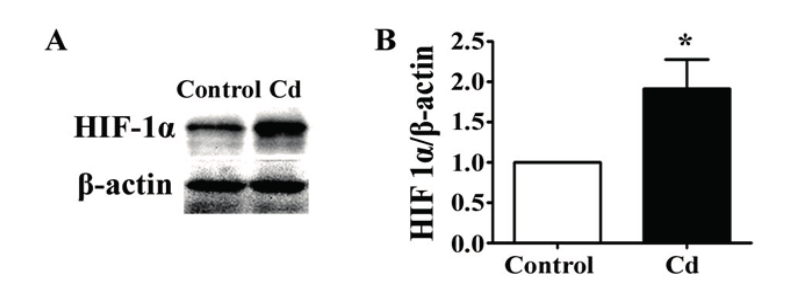
Figure 4. The effects of Cd on HIF-1 α in A549 cells. ( A ) Representative immunoblot of HIF-1 α and β -actin in 1 μ M Cd-treated A549 cells for 24 h. ( B ) Densitometry analyses of the blots of HIF-1 α / β -actin. n = 3; * , p <